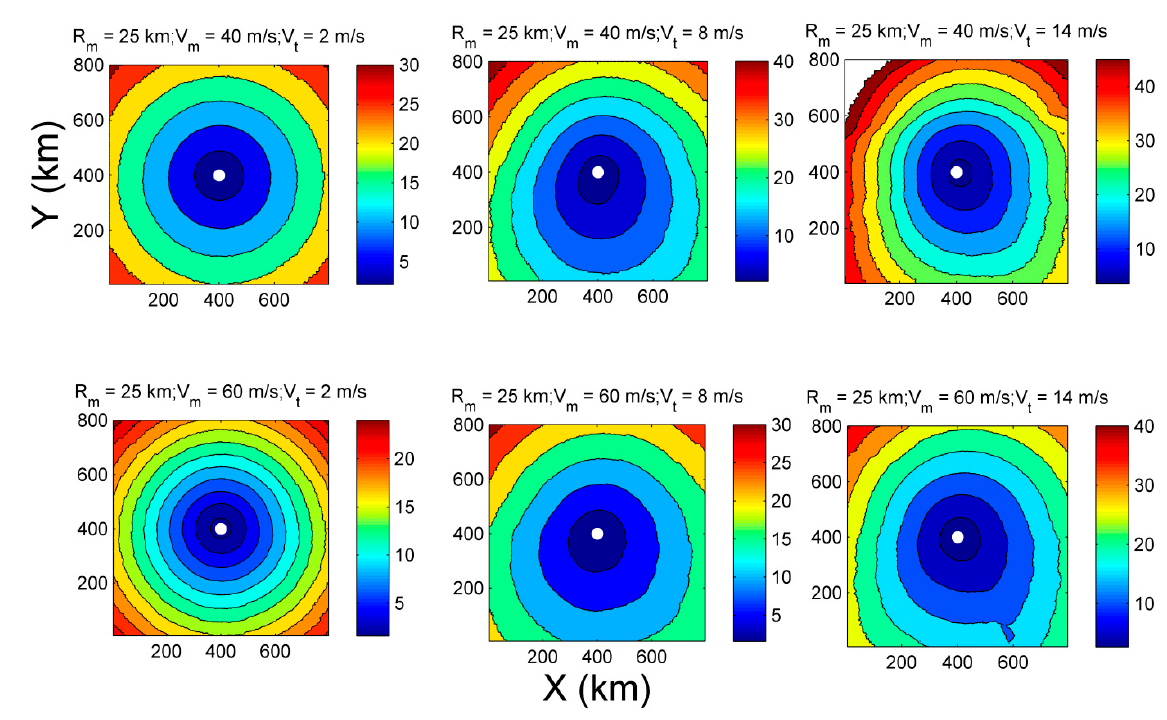
Figure 3. The spatial variation of T # for different TC characteristics (as listed in the subtitle).